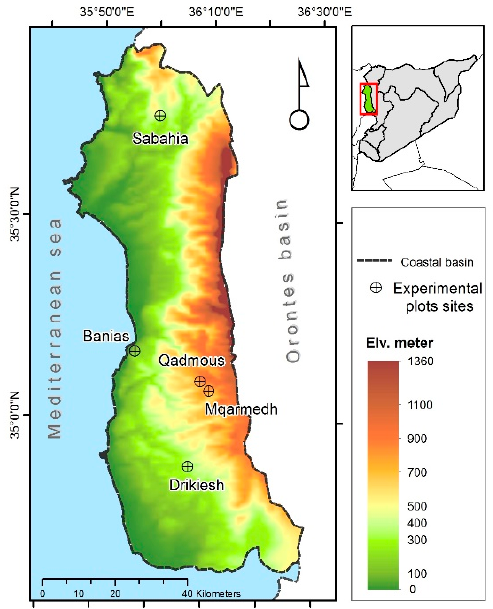
Figure 1. The coastal region of Syria and locations of the experimental plots.